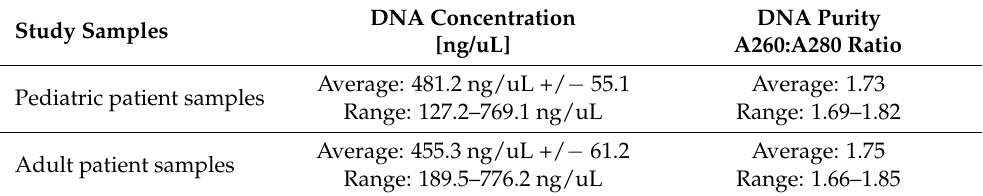
Table 2. DNA isolation and